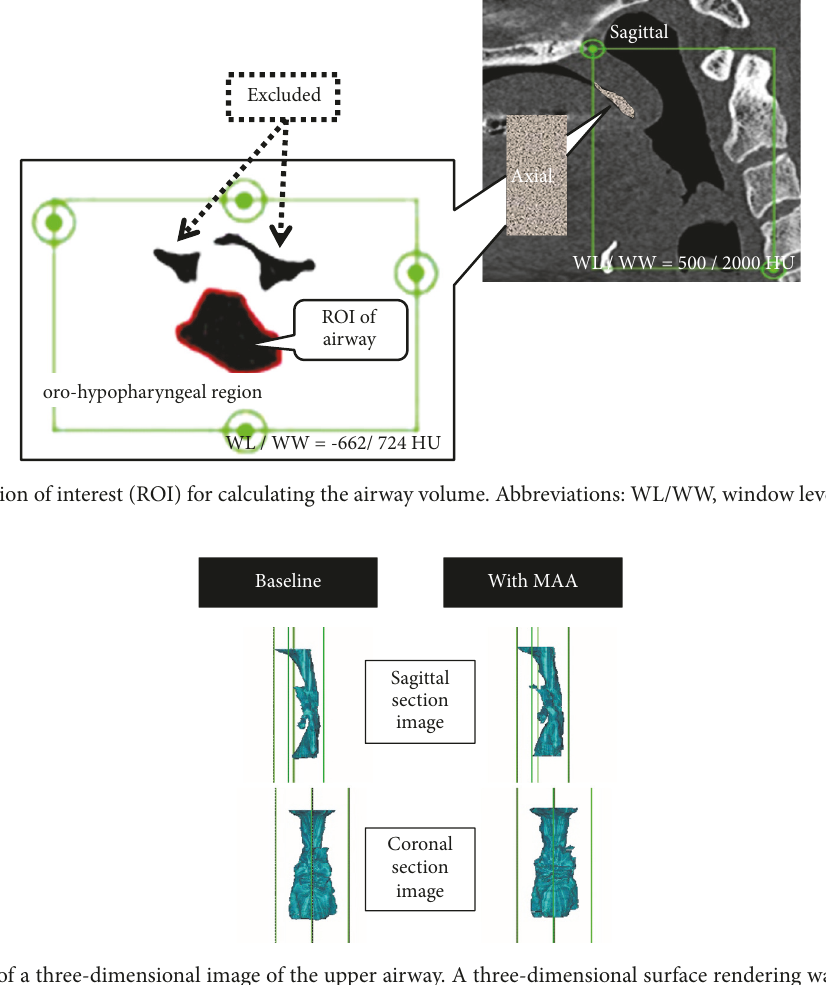
Figure 6: An example of a three-dimensional image of the upper airway. A three-dimensional surface rendering was constructed using all the airway regions of interest in the oro-hypopharyngeal region using multislice computed tomography data at baseline and data with the mandibular advancement appliance